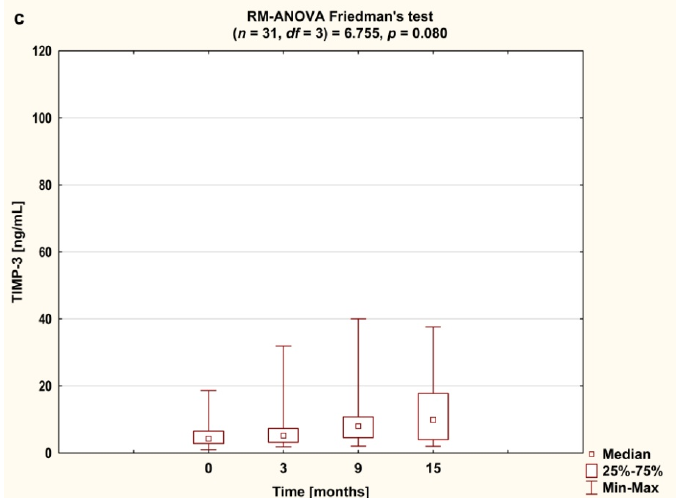
Figure 5. Temporal course of serum ADAMTS-4 ( a ), ADAMTS-5 ( b ) and TIMP-3 ( c ) levels in RA patients during 15-month anti-TNF-α therapy. Results expressed as median and interquartile (25th–75th percentile) range. Data analyzed using one-way repeated measures analysis of variance (RM-ANOVA) Friedman’s test. Differences noted for all variables considered significant at p < 0.0083 by applying Bonferroni correction. a statistically significant differences compared to baseline.